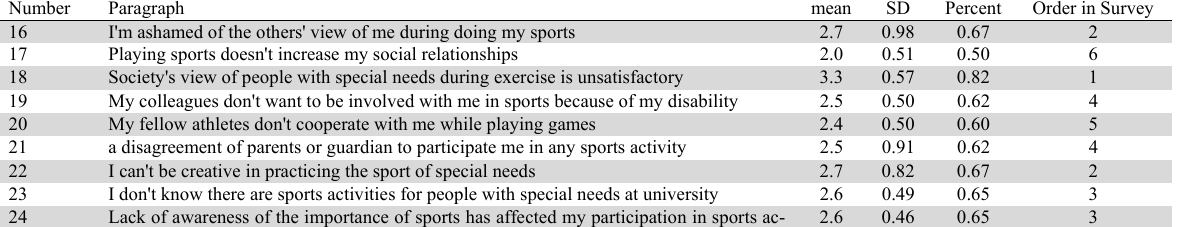
Arithmetic mean, standard deviation and relative importance of the third area of the instrument, which is the social sphere